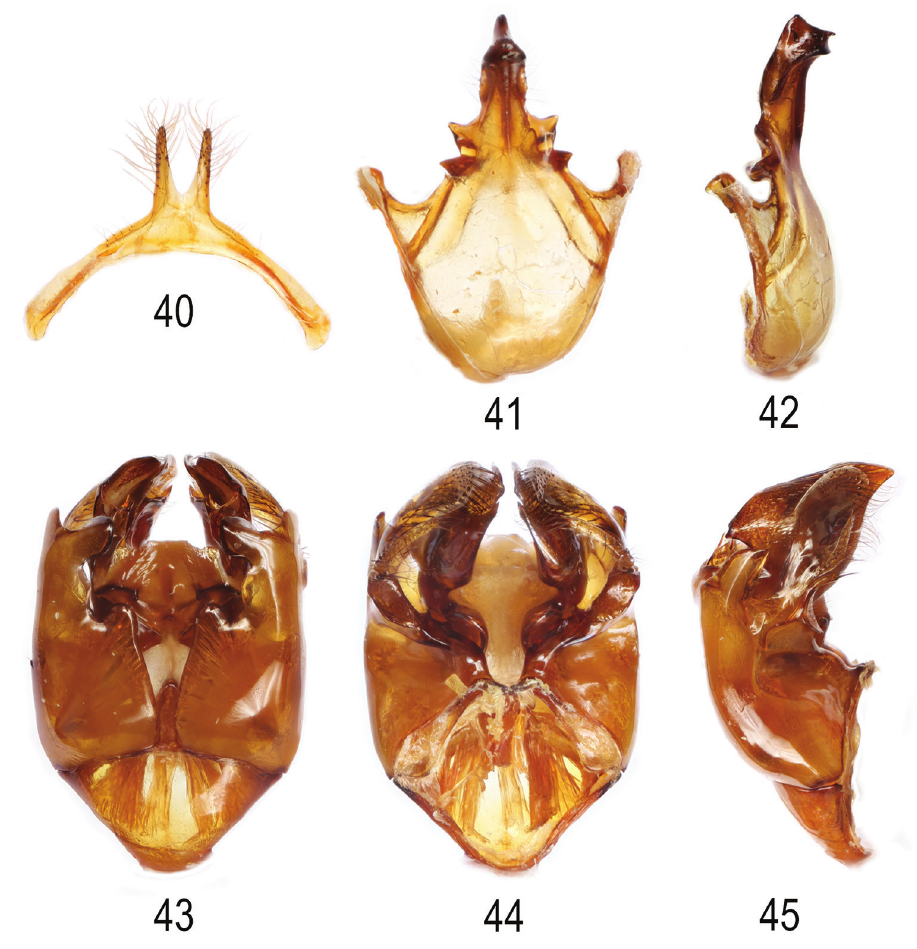
Figures 40–45. Male terminalia of E. coerulescens (Mexico: Nuevo León, ECO-TAP-E-104040). 40 Seventh metasomal sternum in ventral view 41, 42 Eighth metasomal sternum in ventral and lateral views 43–45 Genital capsule in dorsal, ventral, and lateral